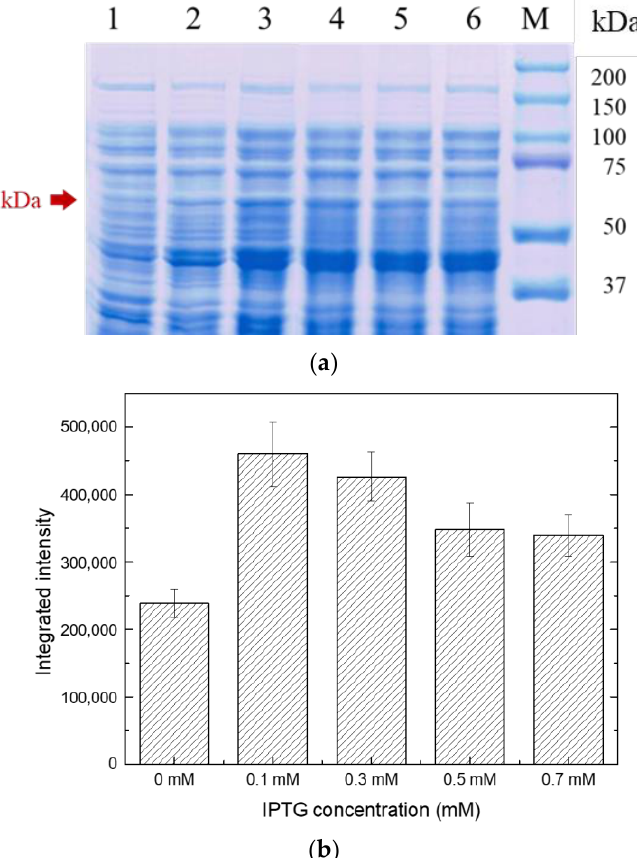
Figure 2. ( a ) SDS-PAGE electrophoresis of recombinant protein induced by different IPTG concentrations. Lane M: marker (kDa); Lane 1: pET21b; Lane 2: not induced; Lane 3: 0.1 mM; Lane 4: 0.3 mM; Lane 5: 0.5 mM; Lane 6: 0.7 mM. ( b ) ImageJ analysis of the protein amount induced by different IPTG